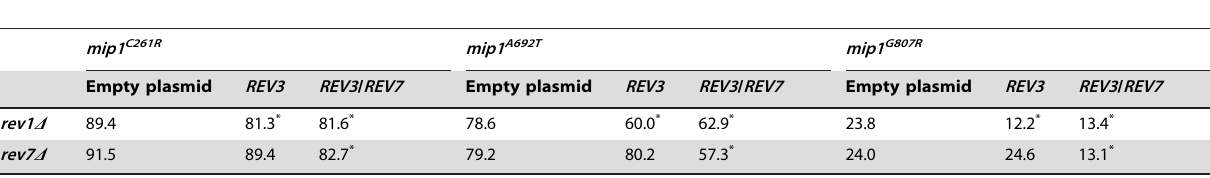
Table 4. Petite frequency in mip1 mutant strains deleted of REV1 or REV7 and overexpressing REV3 and REV7 .